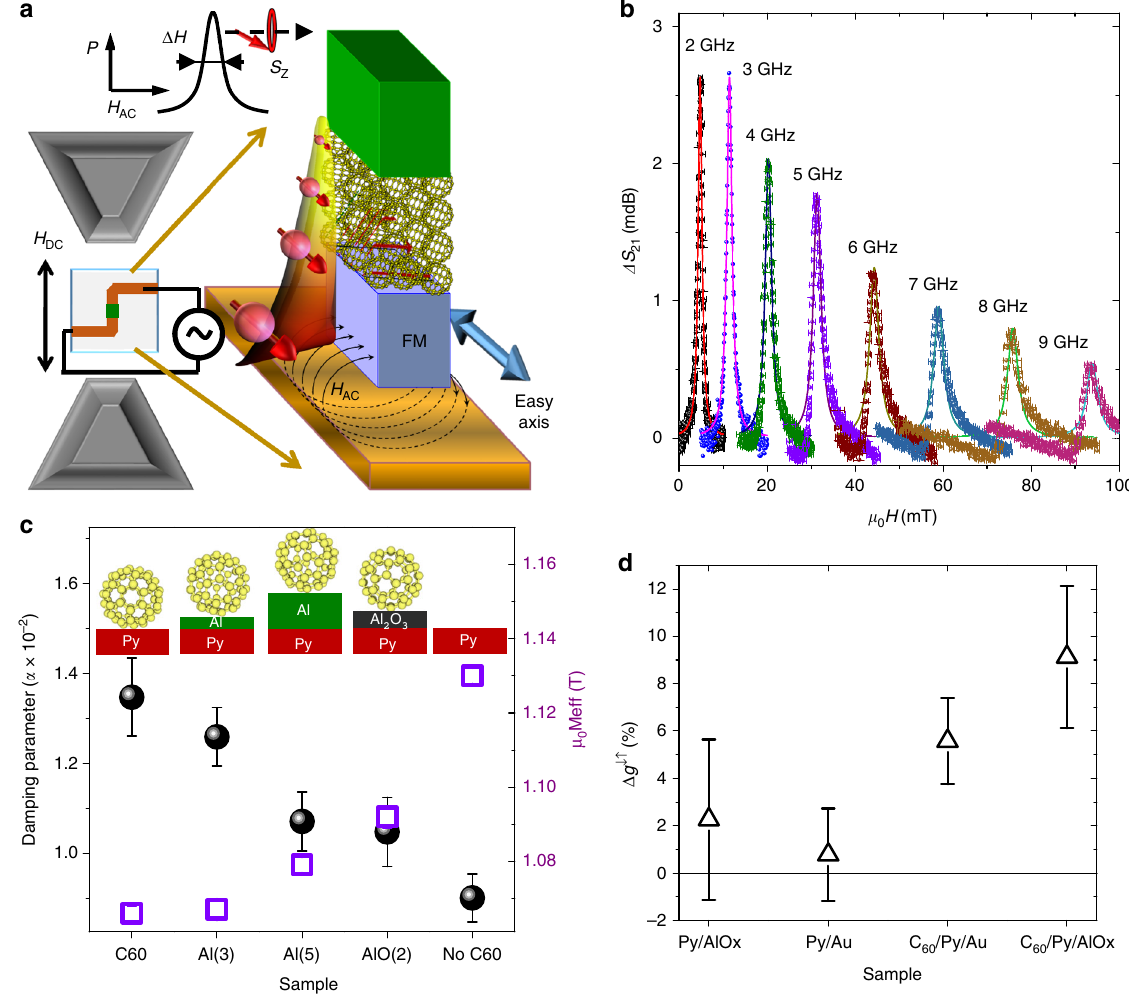
Fig. 1 FMR spin pumping in C 60 . a Principle of operation: the power P absorbed by the ferromagnet FM when the frequency of a microwave fi eld H AC matches the electron spin oscillation S z in a DC magnetic fi eld H DC is dissipated via spin waves used to manipulate the optical properties of an adjacent C 60 fi lm. b . FMR measured in Py fi lms coated with C ω Δ S 60 . The resonant frequency 0 for the power absorbance ( 21 parameter) increases with the applied DC fi eld. c . Change in effective magnetization M α (dots) for Py with or without C eff (open squares) and Gilbert damping 60 . The presence of an Al/Al 2 O 3 spacing layer between the Py and C 60 hinders the magneto-molecular coupling (numbers in brackets are the thickness of the spacer in nm). d . Effect of light irradiation in the spin mixing conductance g ↓↑ . A signi fi cant enhancement of ~8% is observed in samples with a C 60 /Py interface. Error bars in c and d are the mean square error in the Lorentzian fi t of the resonance peaks and the Kittel